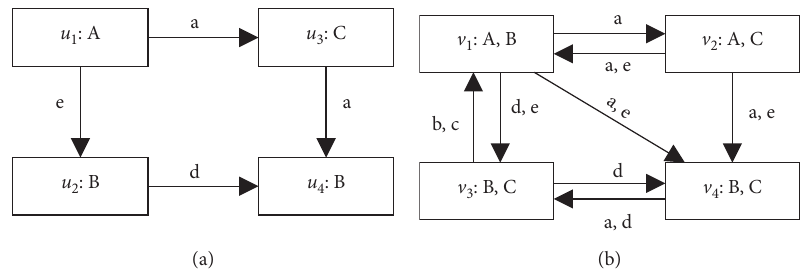
Figure 3: Knowledge multigraphs. (a) Query multigraph. (b) Data multigraph.